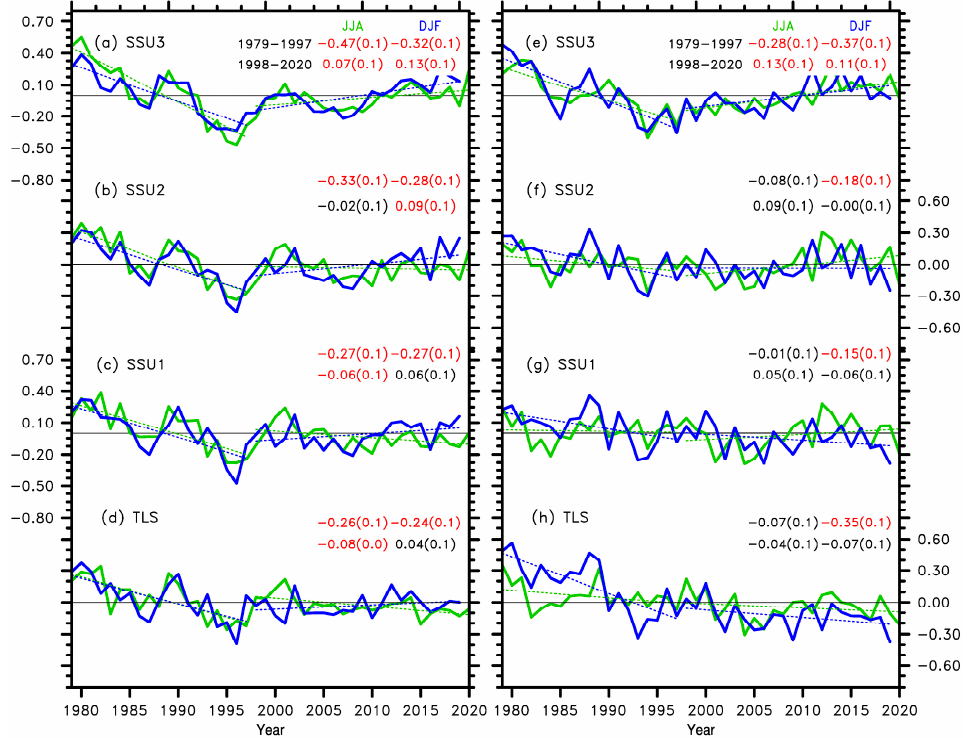
Figure 7. Similar to Figure 3, but for the time series of multi-model ensemble mean stratospheric temperature anomalies over 1979–2020 in the ( a – d ) NH and ( e – h ) SH in SSU channel 3 ( a , e ), 2 ( b , f ), 1 ( c , g ), and TLS ( d , h ).